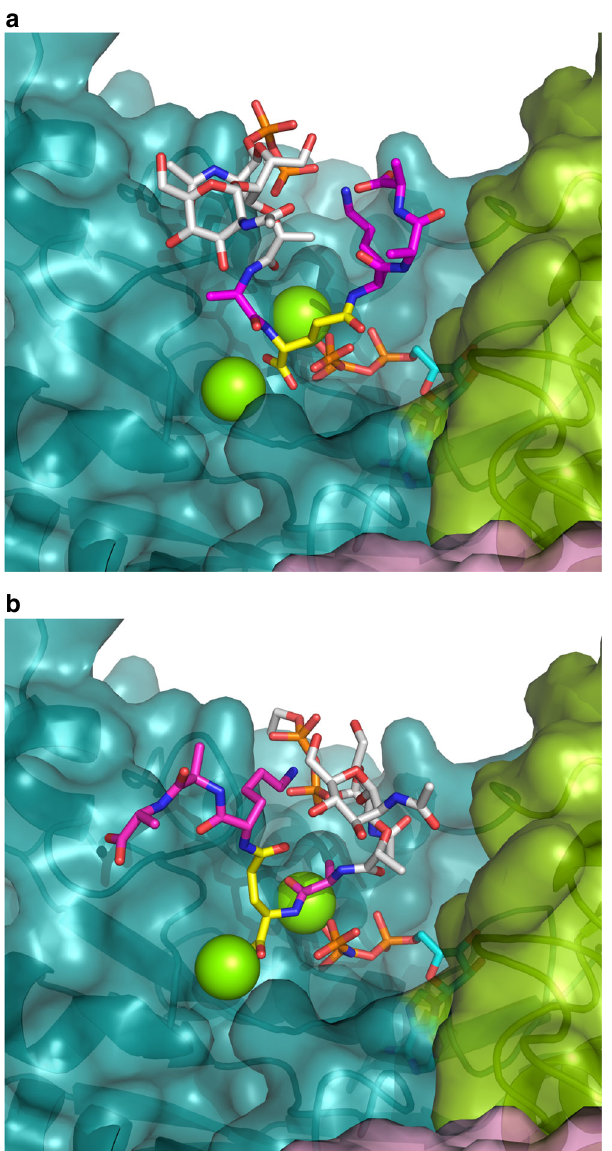
Fig. 6 Models of the substrates ATP and lipid II docked in MurT active site. Representative poses of the two best score dockings are shown ( a , b ). The color scheme of MurT/GatD is as in Fig. 3. ATP is in cyan with the phosphates in orange. For docking, a lipid II variant was used with the undecaprenol replaced by ethanol to avoid non-speci fi c hydrophobic interaction. The disaccharide and ethanol are in white, the pentapeptide is in magenta except the D-glutamate in yellow. Mg 2 + ions are shown as green spheres